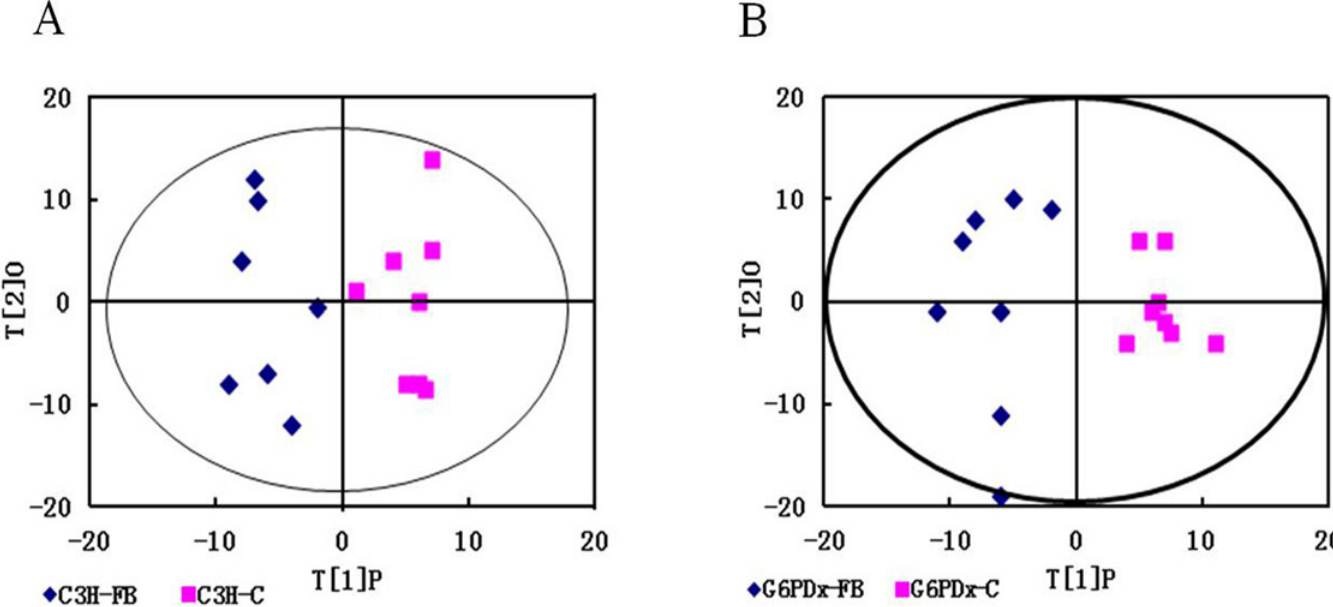
Fig 4. OPLS-DA scatter plots of GC/MS data of extracts from the liver of mice. Orthogonal partial least-squares discriminant analysis (OPLS-DA) score plots (t(1)P/ t(2)O) of the liver of C3H group (A) and G6PDx group (B).